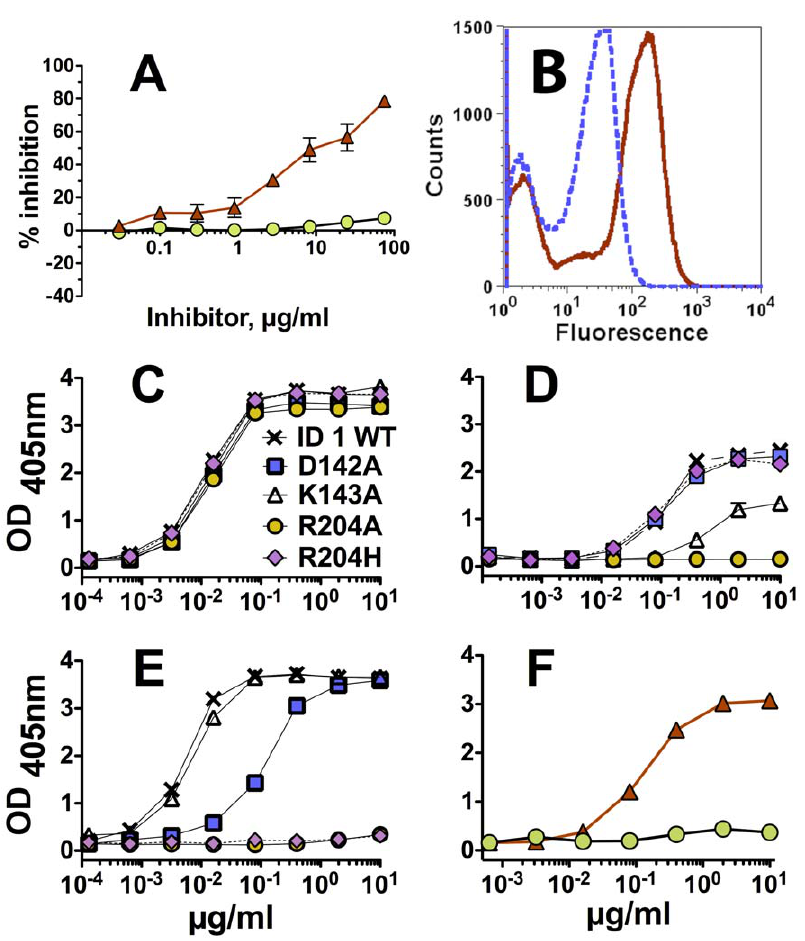
Figure 3. Anti-fHbp mAbs JAR 1 and mAb502 recognize overlapping epitopes on the C-terminal domain of fHb. Panel A. Inhibition of binding of a fixed concentration (1 m g/ml) of anti-fHbp mAbs to recombinant fHbp as measured by ELISA. Red triangles: inhibition of binding of mAb502 (IgG2a) by JAR 1 (IgG3). Green circles: Inhibition of binding of JAR 1 by mAb502. Error bars represent ranges in independent assays. Panel B. Binding of JAR 1 to yeast clones displaying randomly mutated fHbp on their surface. A representative clone is positive for binding to JAR 1 (red solid line) and a control anti-fHbp mAb, JAR 5 (blue dashed line). Panels C, D, E. Binding of anti-fHbp mAbs to mutants of recombinant fHbp as measured by ELISA. Crosses, wild-type (WT) fHbp ID 1; Blue squares, D142A mutant; White triangles, K143A mutant; Orange circles, R204A mutant; Pink diamonds with dashed black line, R204H mutant. Panel C. Binding of JAR 5 (positive control, data are superimposed). Panel D. Binding of JAR 1. Panel E. Binding of mAb502. Panel F. Binding of JAR 1 (red triangles with solid red line) or mAb502 (green circles with dashed line) to fHbp ID 2, which has H204 instead of R204 in ID 1. Wells were coated with 2 m g/ml of wild-type or mutant fHbp.